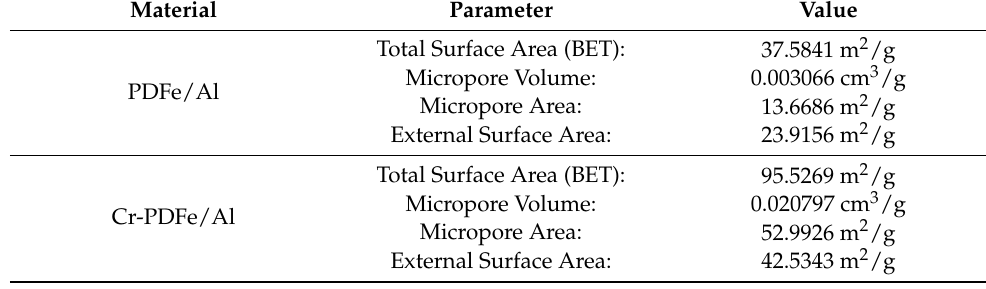
Figure 5. Porosity of the PDFe/Al before and after Cr(VI) adsorption. Table 4. Shows a summary of the porosity of PDFe/Al before and after Cr(VI) adsorption.